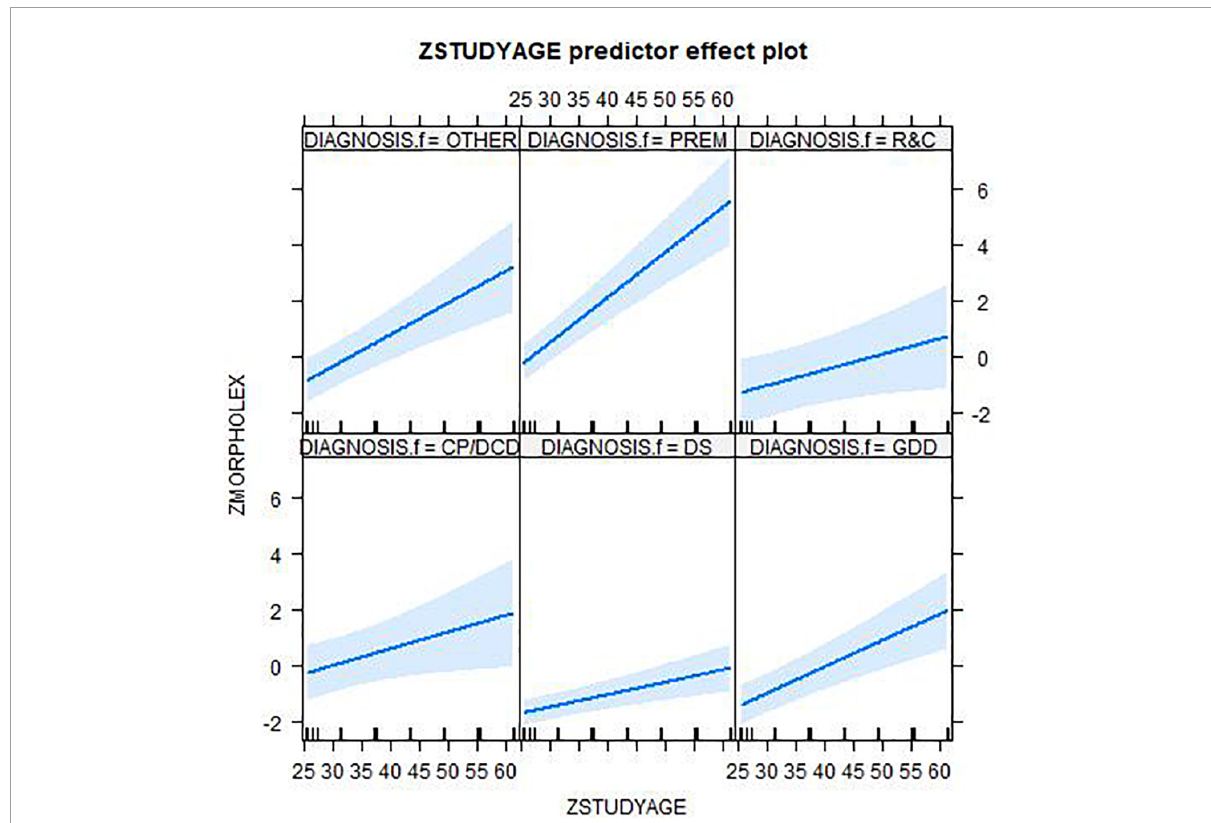
FIGURE2 Effects plots by diagnosis from linear mixed effects models with ZMORPHOLEX dependent variable: ZMORPHOLEX ∼ DIAGNOSIS.f * ZSTUDYAGE + (1 + STUDYAGE|CHILD). Diagnoses: CP/DCD, cerebral palsy/developmental coordination disorder; DS, down syndrome; GDD, global developmental delay; OTHER, other syndromes than DS; PREM, prematurely born; R&C, disorders of relating and